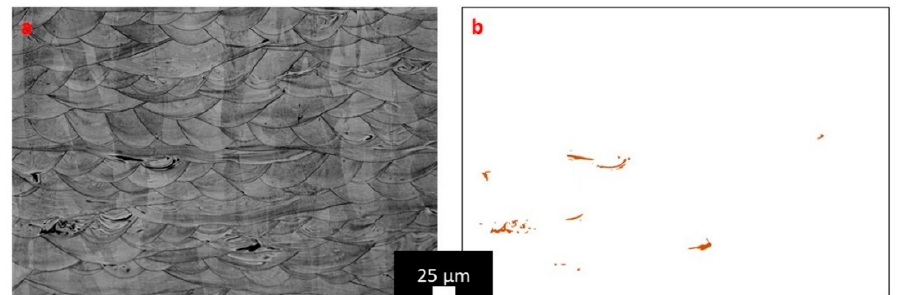
Figure A2. LOM images of AB IN625mod version after etching ( a ) and post-processed ( b ) to highlight the Ti-rich segregations.